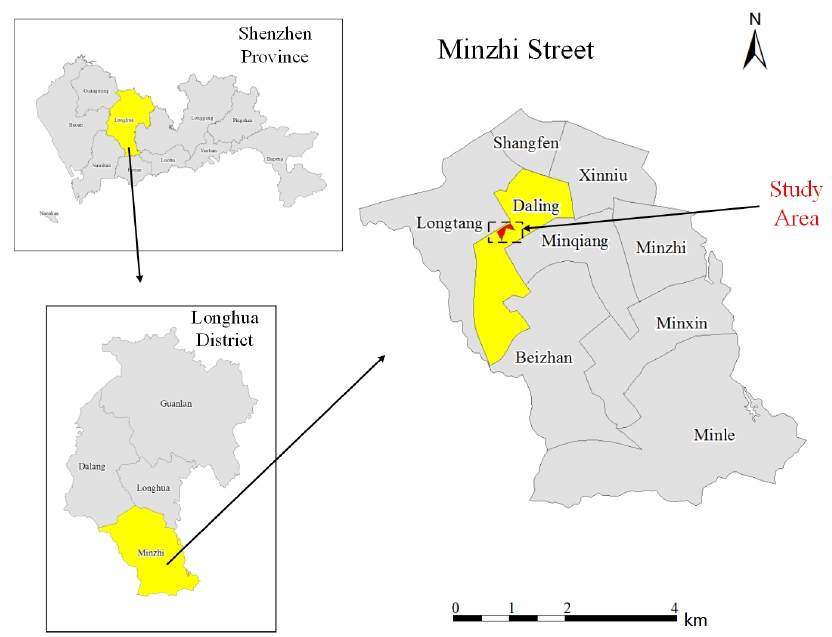
Figure 6. Location of the land considered in the case study.